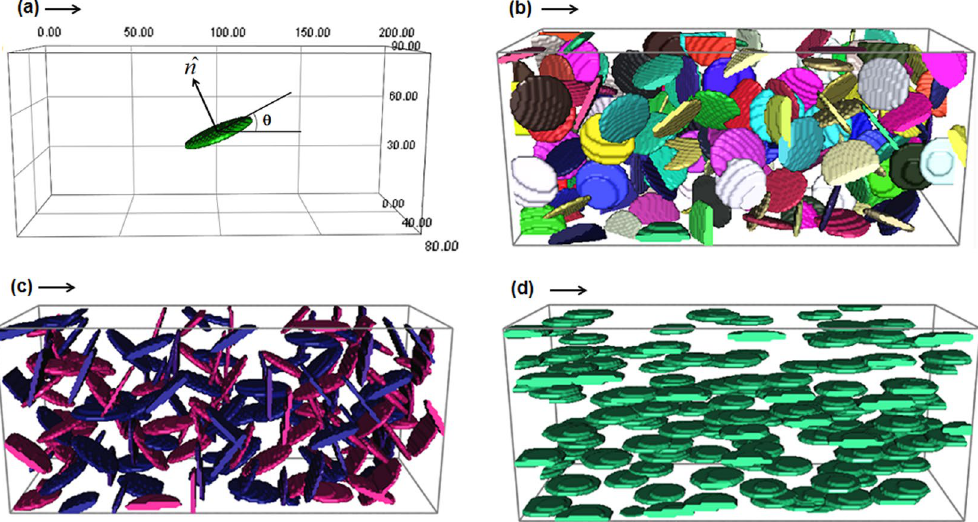
Figure 1. Ellipsoidal particles suspended in the matrix of dimension 200 × 90 × 80 grids. An arrow in each figure represents the direction of applied electric field. The eccentricity for all ellipsoidal particles is 0.1. ( a ) Only one particle submerged in the matrix with angle of inclination θ to electric field direction and the normal vector ˆ n ; ( b ) 173 ellipsoidal particles with random orientation; ( c ) 173 particles with some extents of preferred orientation toward vertical direction; ( d ) 173 aligned particles along current flow